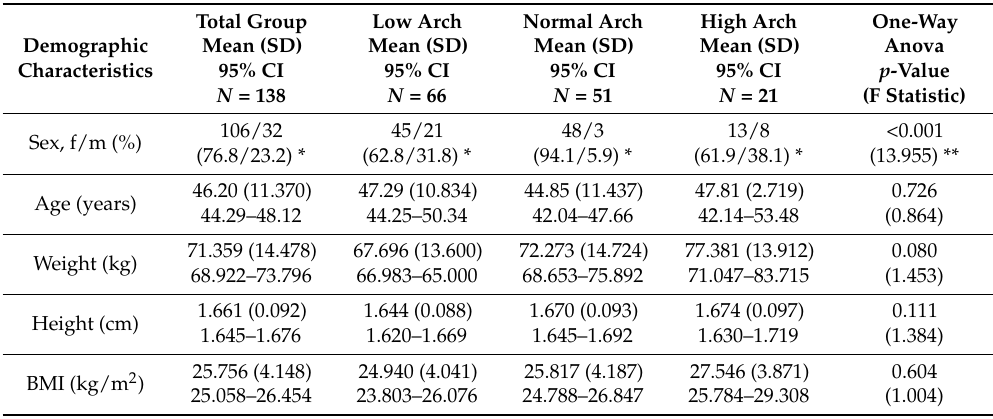
Table 1. Demographic characteristics of the sample